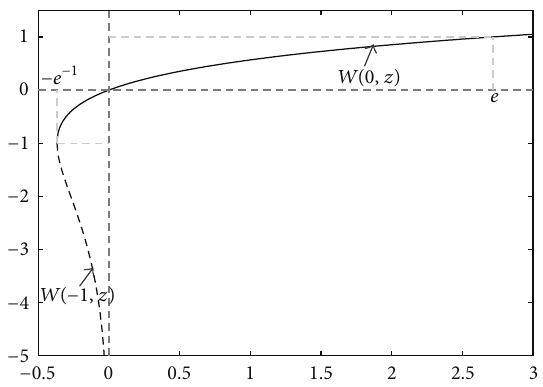
Figure 1: The two real branches 𝑊(0, 𝑧) and 𝑊(−1, 𝑧) of Lambert 𝑊